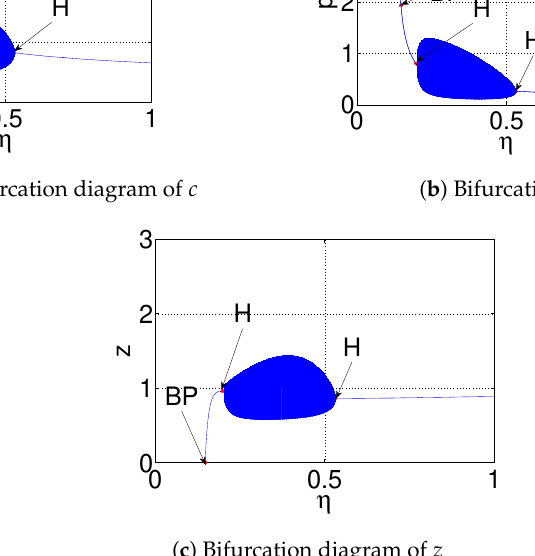
Figure 16. Bifurcation diagrams of system (1) taking η as the bifurcation parameter, while the others remain unchanged, as in Figure 6. Here, the zooplankton free equilibrium E 1 ( (cid:101) c , (cid:101) p ,0 ) is stable when 0 < η < η [ tc ] = 0.147603, and the interior equilibrium (cid:98) E ( (cid:98) c , (cid:98) p , (cid:98) z ) is stable when η ∈ ( 0.147603, η [ H ] 1 = 0.198177 ) ∪ ( η [ H ] 2 = 0.530864,1 ) and unstable with a periodic solution when η ∈ ( 0.198177,0.530864 ) . Here, ‘BP’ stands for the transcritical bifurcation